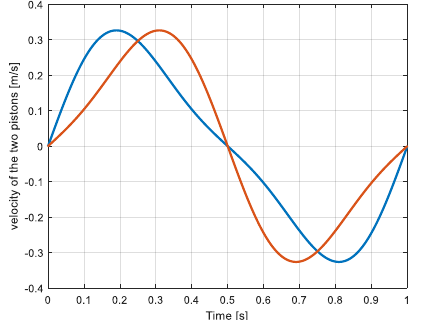
Figure 8. Velocity of the pistons (m/s). (red: left, blue: right).